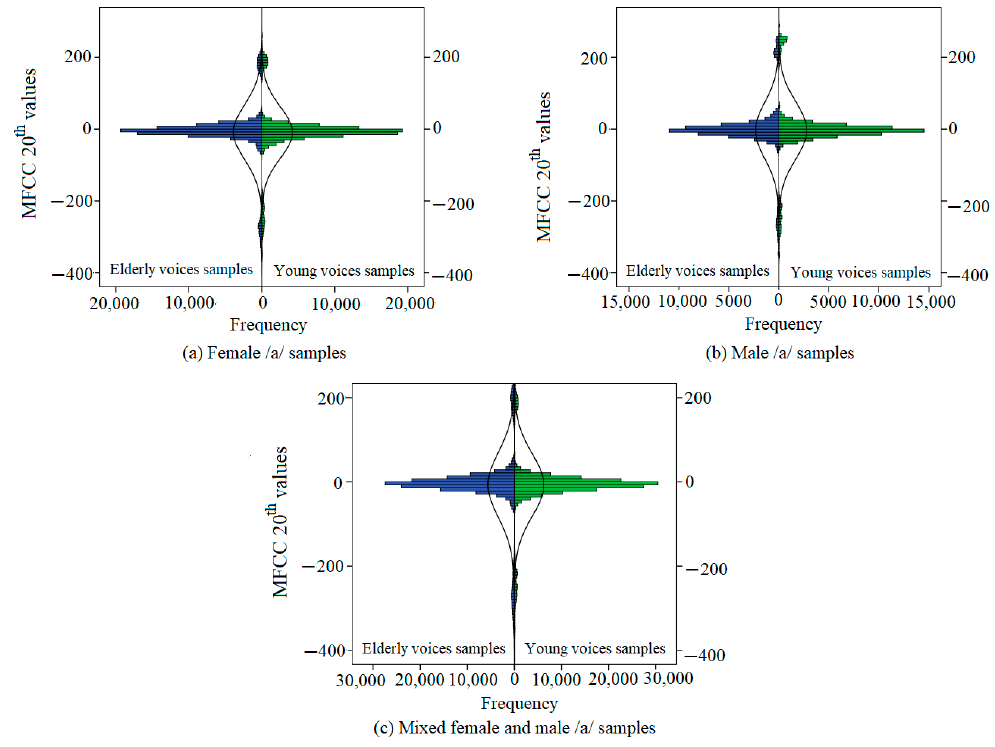
Figure 1. Histograms of the 20-dimensional MFCCs extracted from elderly and young voices.